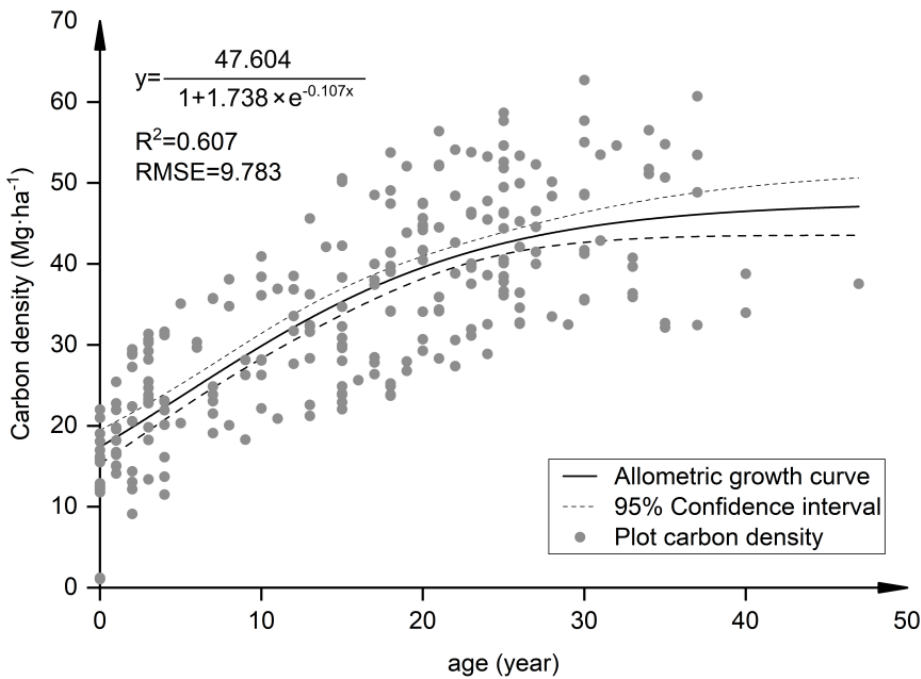
Figure 2. Scatterplot diagram of the allometric growth curve fitting.